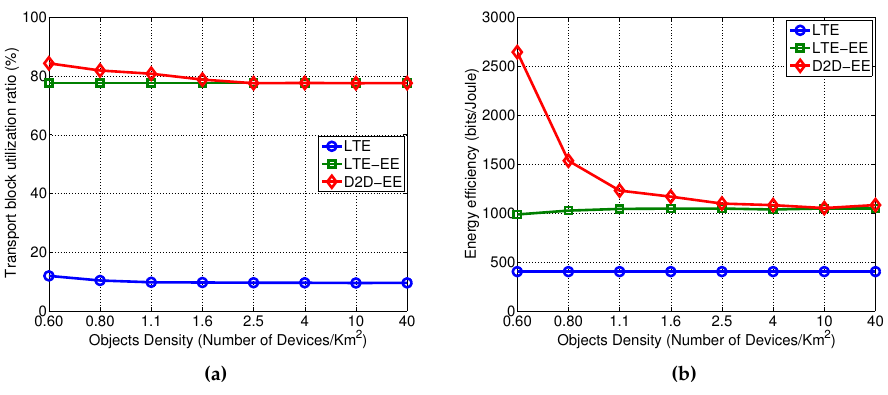
Figure 6. Performance for varying device density in the cell. ( a ) Transport Block utilization; ( b ) Energy